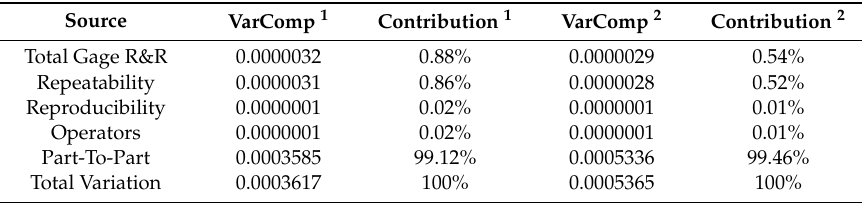
Table 2. Variance components for the characteristic diameter and